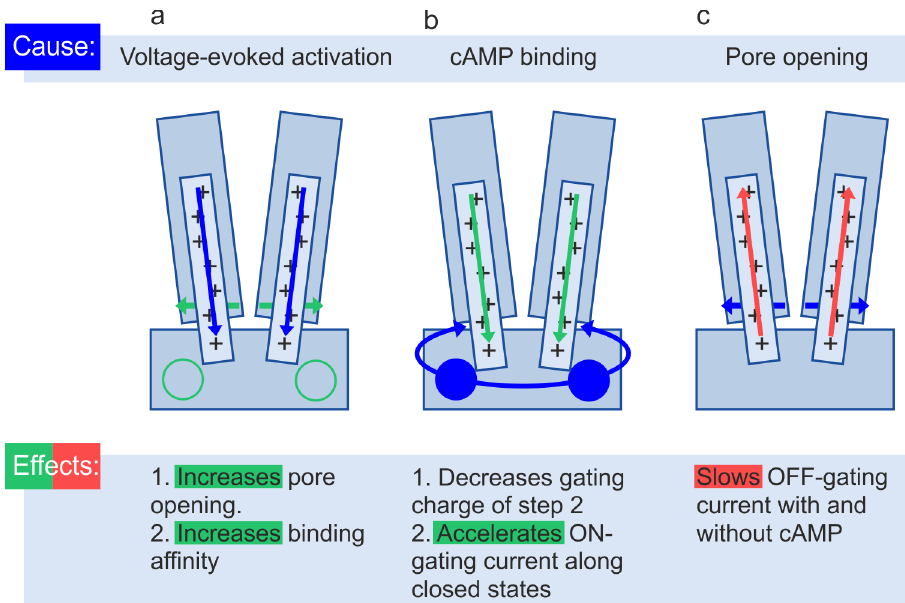
Fig 6. Cartoons illustrating the mutual interactions between mutual stimuli. The graphs show schematically two S6-helices forming the inner gate at their inner end, two S4-helices being the voltage sensor and the CNBD with two of the four binding sites (circles). Blue color symbolizes a cause, green and red color an activating and inhibiting effect, respectively. (a) Effects of voltage-evoked activation on binding affinity and P o . (b) Effects of cAMP binding on gating charge and ON-gating current. (c) Effects of pore opening on OFF-gating current. For further explanation see